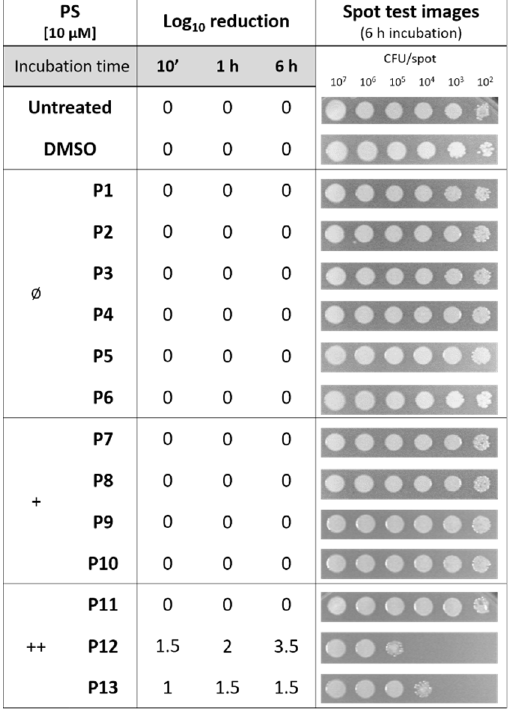
Figure 1 . Analysis of intrinsic toxicity of diaryl-porphyrins (P1-P13). PSs were administered at a con- centration of 10 µM to samples of P. aeruginosa PAO1 at decreasing concentrations (from 10 9 up 10 4 CFU/mL). After dark incubation for 10 min, 1 and 6 h, volumes of ~5 µL of each sample were replica plated on LB agar. After overnight incubation at 37 °C, the growth spots were checked. In the second column, Log10 reduction values represent the mean of three independent experiments for each dark incubation. Representative images reported in the last column refer to growth spots at the corre- sponding bacterial denisities (from 10 7 to 10 2 CFU/spot) upon 6 h of dark incubation with the tested PS. Each experiment has been repeated at least three times with independent cultures.